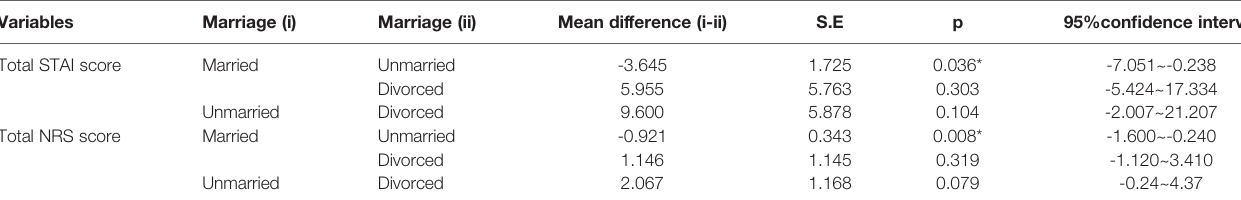
TABLE 3 | The effect of different marital status on women ’ s NRS score and STAI score (LSD). Variables